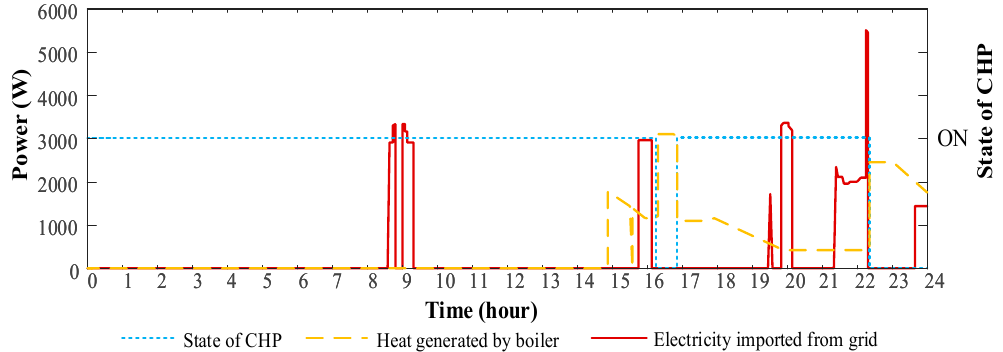
Figure 14. The state of CHP and the amount of imported gas and electricity in a day.